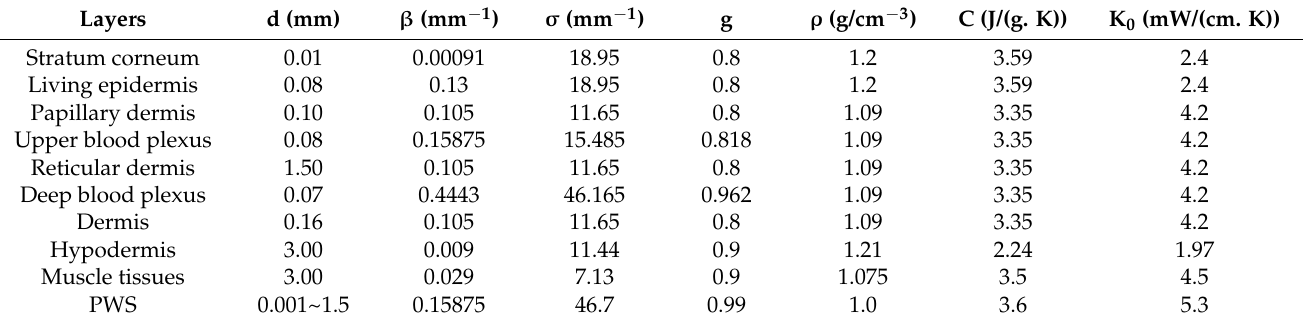
Table 1. Thickness, optical and thermal parameters of the skin model at 840 nm